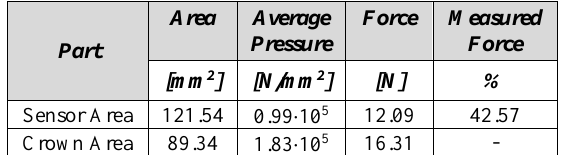
Table 2. Percentage of forces which is applied to the sensor when using the Deep3R6 sensor housing.